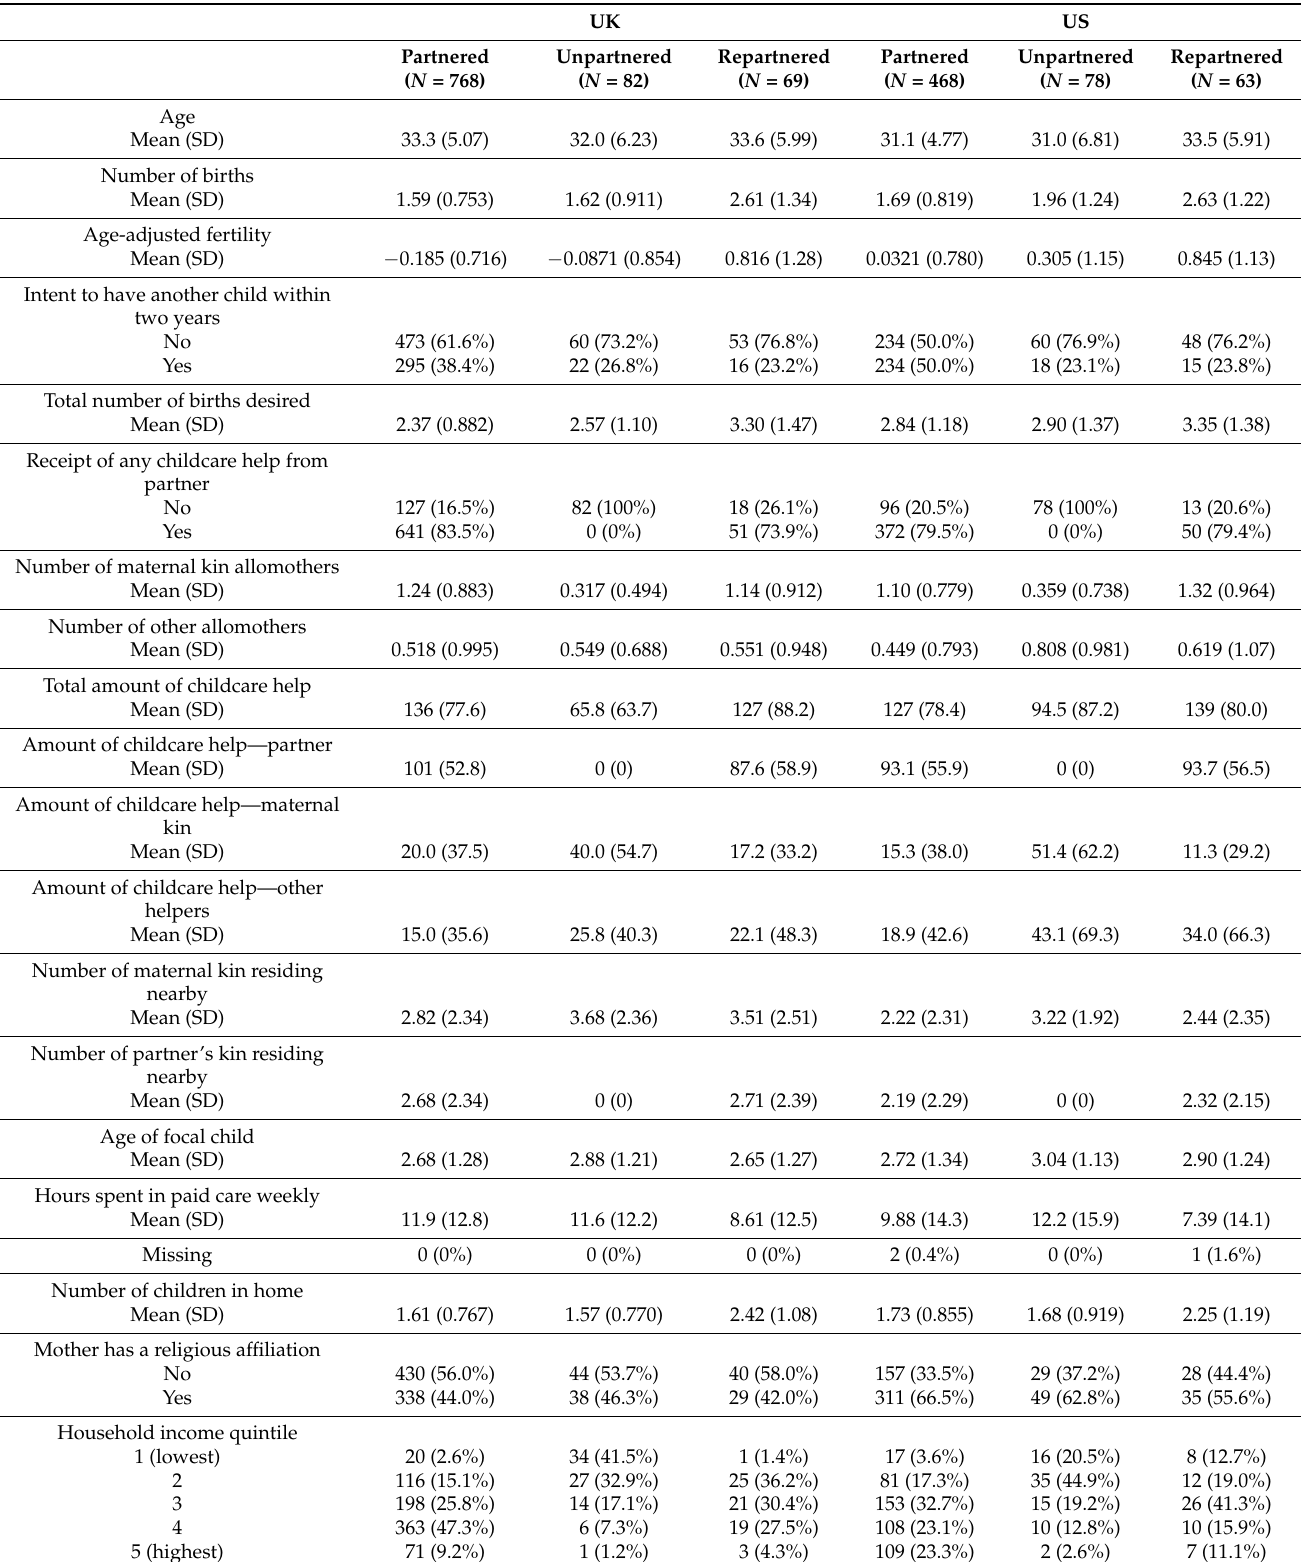
Table 1. Participant characteristics by country of residence and partnership status. See Materials and Methods for details on calculating age-adjusted fertility and level of alloparental